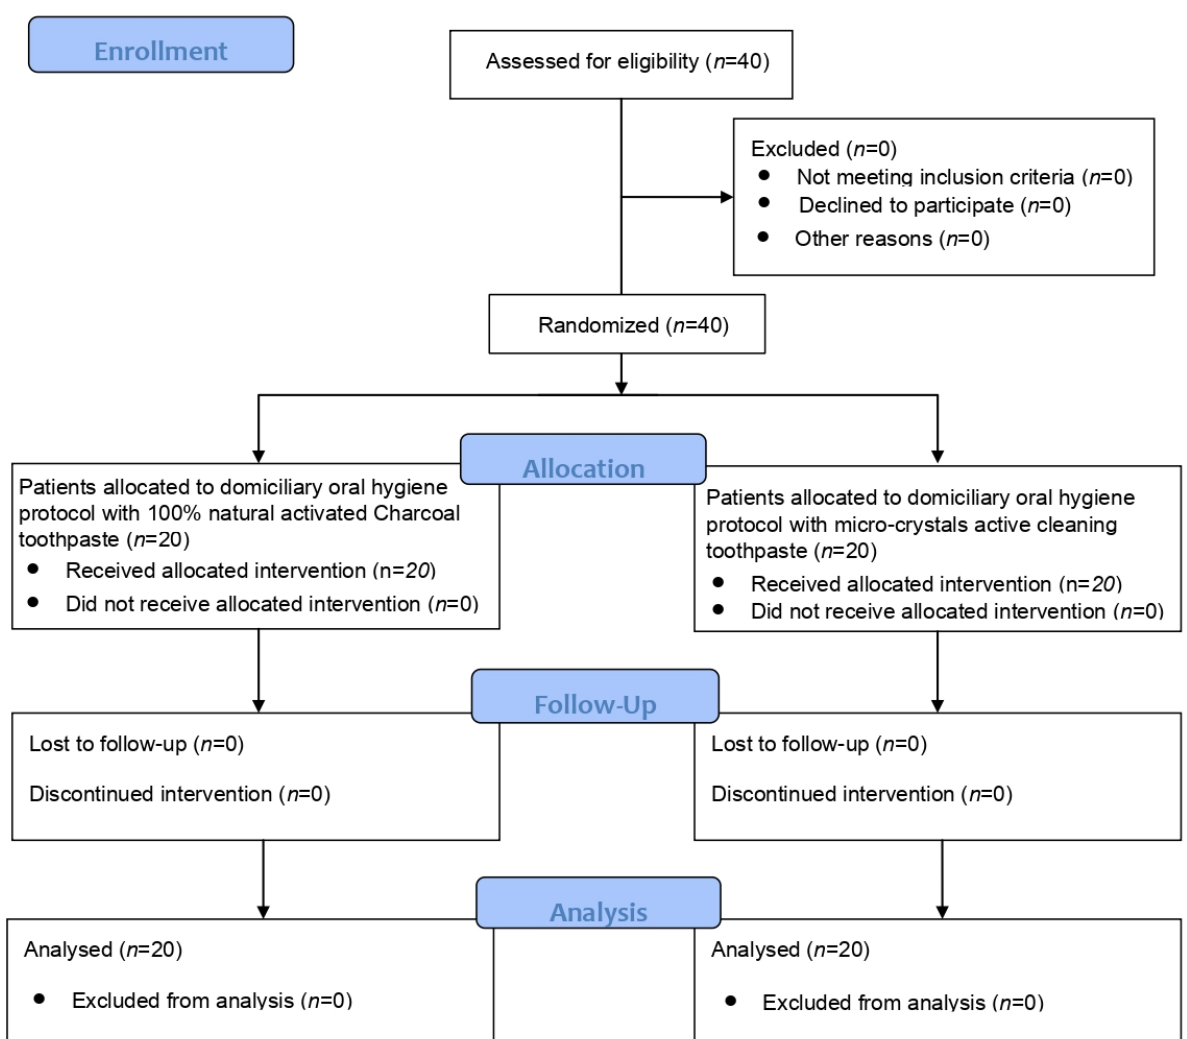
Figure 1. CONSORT flow chart.